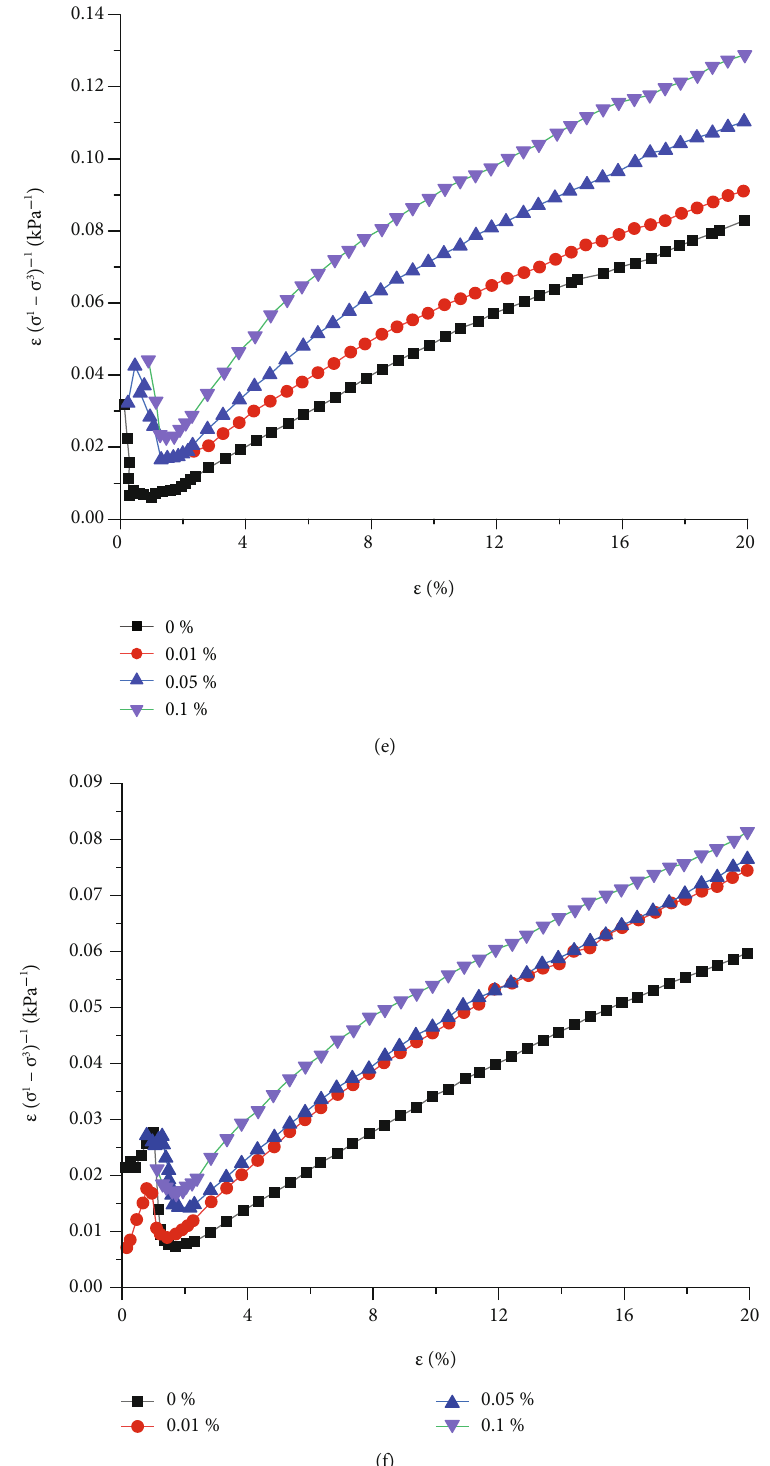
/ ð σ 1 – σ 3 Þ − ε ff erent dry densities. (a) The initial dry density is 1.35g/cm 3 , 100kPa. (b) The initial dry density is Figure 6: The ε a a curve of di 1.35g/cm 3 , 300kPa. (c) The initial dry density is 1.40g/cm 3 , 100kPa. (d) The initial dry density is 1.40g/cm 3 , 300 kPa. (e) The initial dry density is 1.45g/cm 3 , 100 kPa. (f) The initial dry density is 1.45g/cm 3 , 300